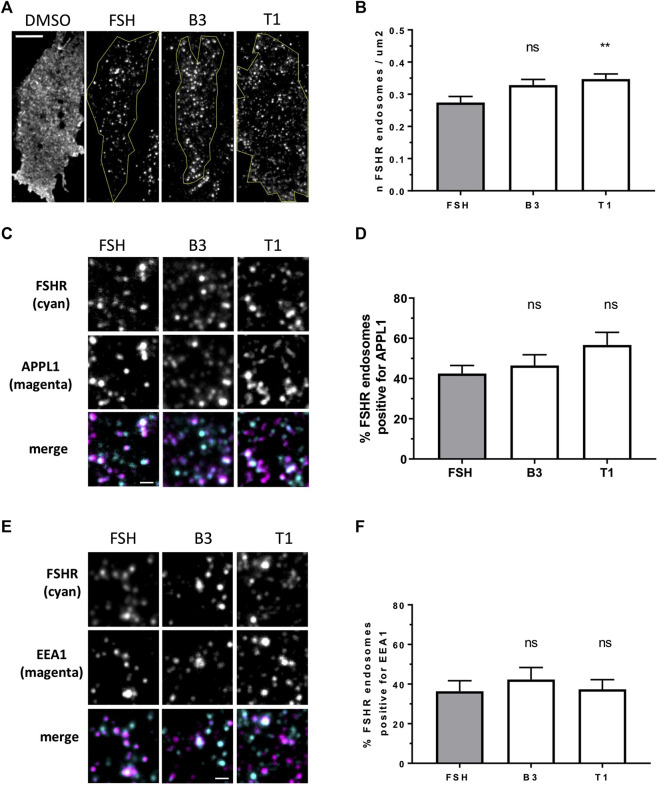
LMW agonists do not alter the endosomal organization of FSHR (A) Representative TIR-FM images of FLAG-FSHR expressing HEK 293 cells treated with either DMSO, FSH (10 nM), B3 or T1 (10 μM) for 5 min. Scale bar = 10 μm. (B) Quantification of FSHR endosomes in stimulated cells from (A); n = 24 cells/condition collected across three independent experiments. One-way ANOVA: **p < 0.01. (C) TIR-FM images of FLAG-FSHR (cyan) and endogenous APPL1 (magenta) in cells stimulated with either FSH (10 nM), B3 or T1 (10 μM) for 5 min. Scale bar = 1 μm. (D) Quantification of FSHR endosomes positive for APPL1 from (C); n = 10–12 cells/condition collected across three independent experiments. (E) TIR-FM images of FSHR (cyan) and endogenous EEA1 (magenta) in cells stimulated with either FSH (10 nM), B3 or T1 (10 μM) for 5 min. Scale bar = 1 μm. (F) Quantification of FSHR endosomes positive for EEA1 from (E); n = 11–12 cells/condition collected across three independent experiments.